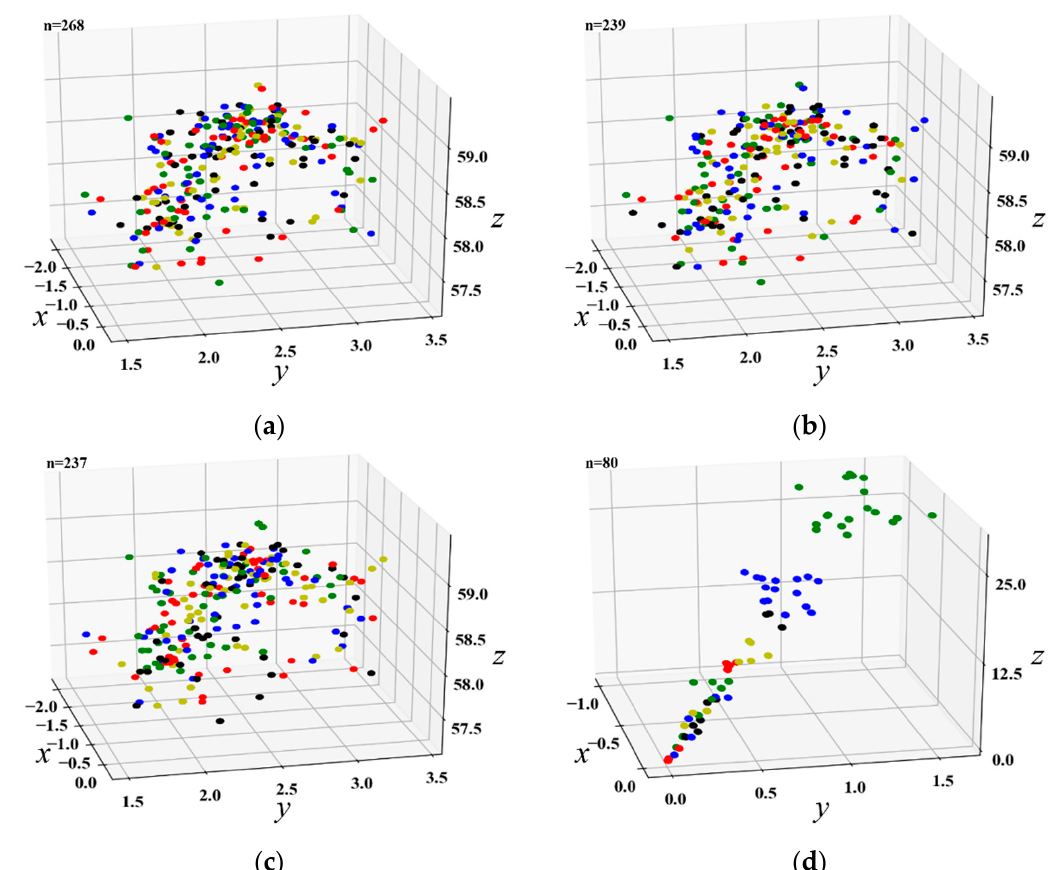
Figure 6. The fruit number results based on the RGB color space clustered by the ( a ) improved mean shift, ( b ) common mean shift, ( c ) maximum–minimum distance, and ( d ) DBSCAN clustering methods.